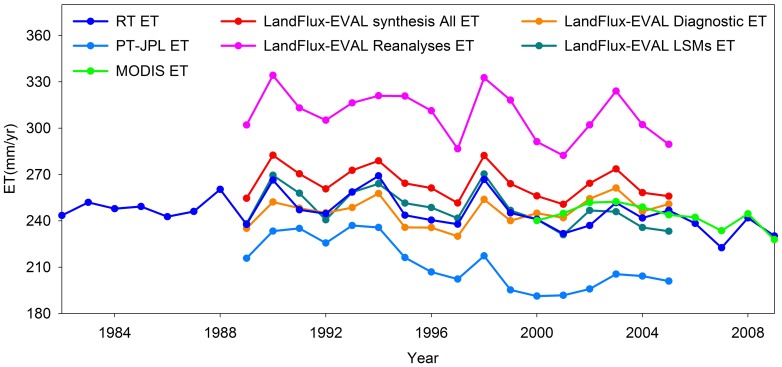
Interannual variability of RT ET, PT-JPL ET, MODIS ET and LandFlux-EVAL synthesis ET datasets.The LandFlux-EVAL synthesis ET datasets included four ensemble products from diagnostic ET data sets (LandFlux-EVAL Diagnostic ET), land surface models (LSMs) ET (LandFlux-EVAL LSMs ET), ET reanalyses dataset (LandFlux-EVAL Reanalyses ET)) and all the three categories (LandFlux-EVAL synthesis All ET).